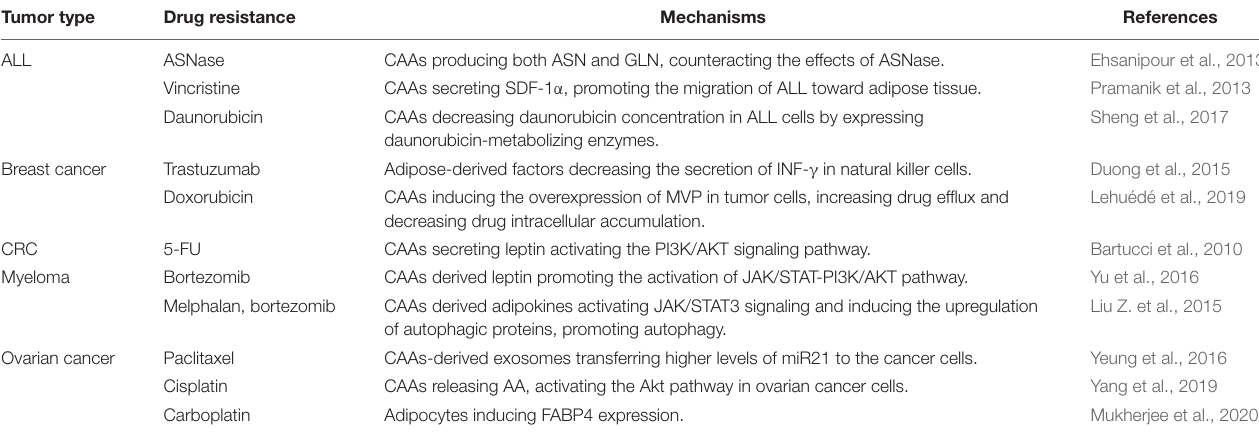
TABLE 6 | Mechanisms of antitumor drug resistance mediated by